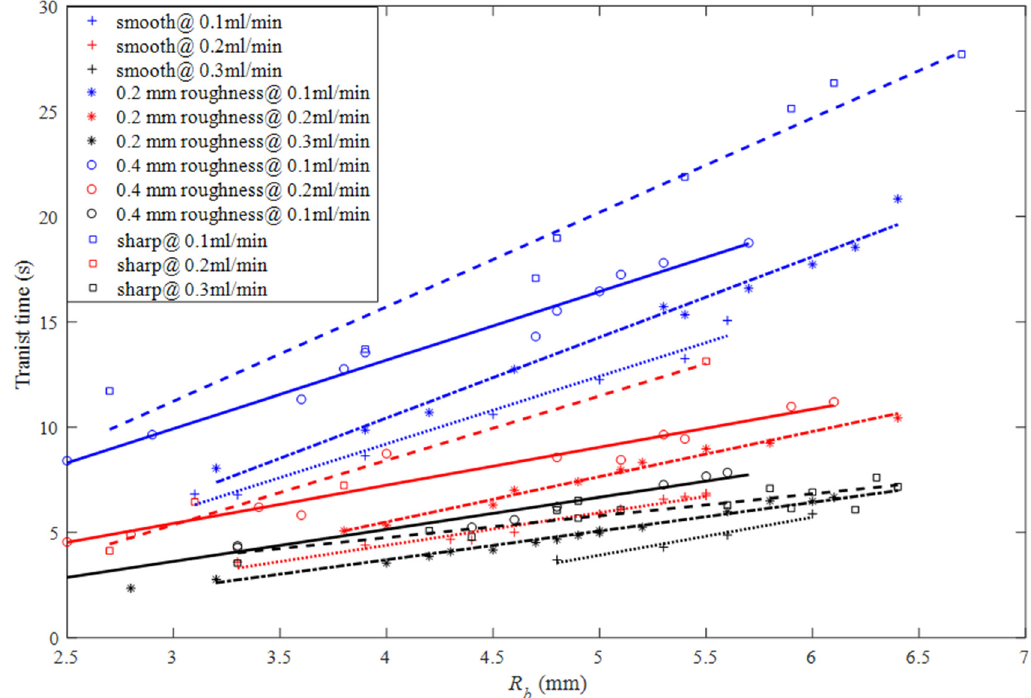
Figure 14. Plots of change in the transit time of bubble at different flow rates, size, and pore geometry.The flowrates are color-coded where black, red and blue corresponds to 0.1, 0.2 and 0.3 mm/min, respectively.